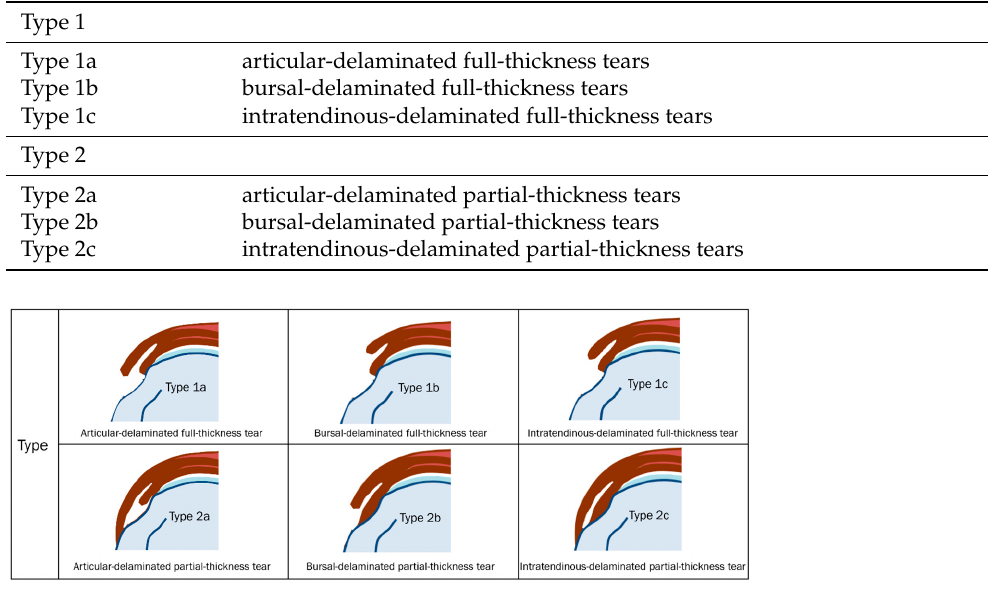
Figure 6. Schematic diagram of the types of delaminated tears of full- and partial-thickness tears by Choo et al. [11]. According to Bierry et al. [30], a delaminated tear is defined as either horizontal in- trasubstance splitting of the bursal and articular layers by a plane of fluid, or differential retraction of the bursal and articular layers regardless of an intervening plane of fluid